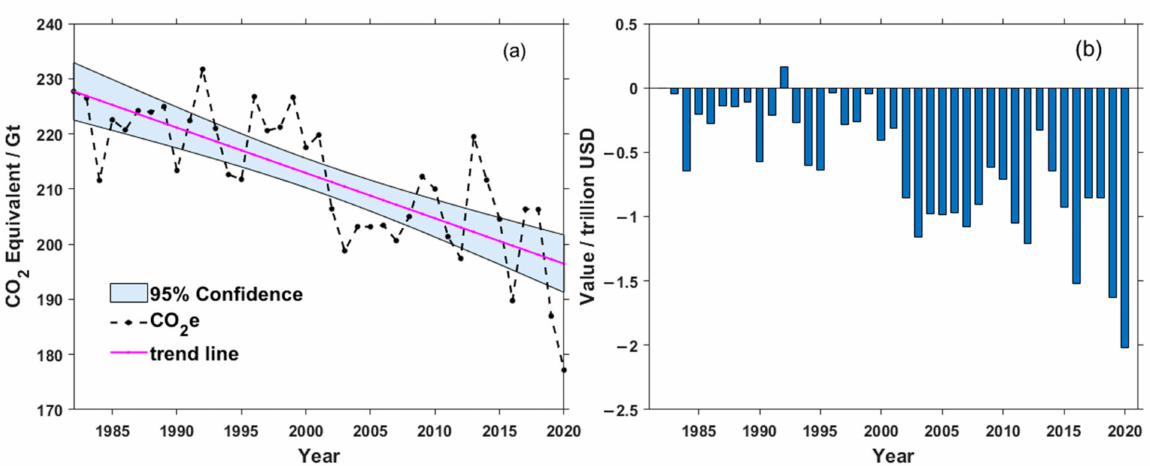
Figure 6. ( a ) Time series of CO 2 equivalent of all-sky SIRF from 1982 to 2020. ( b ) Economic value losses relative to